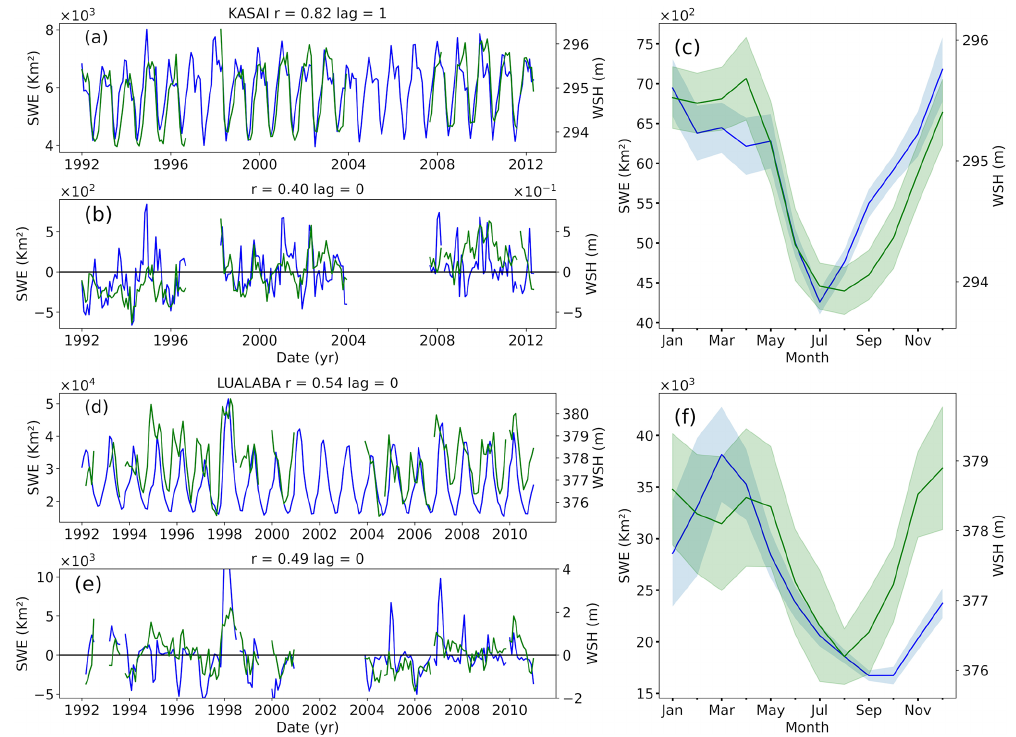
Figure 9. Similar to Fig. 8 using available in situ water stage. A comparison of the monthly SWE (absolute and anomaly values) against the in situ water stage at each subbasin outlet is shown. The blue line is for the SWE, and the green line is for the water stage. The annual cycle for both variables (1992–2015) is also displayed, with the shaded areas illustrating the standard deviations around SWE and discharge